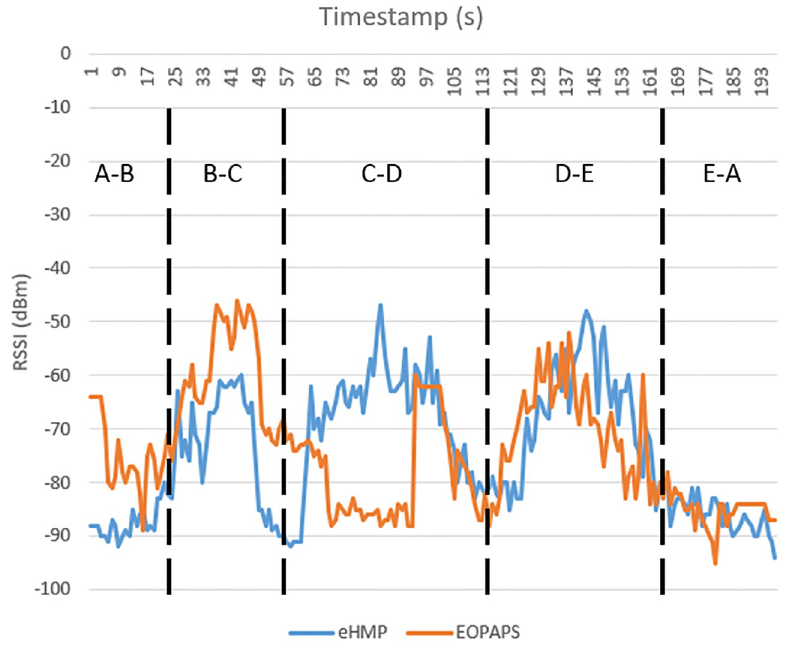
Fig 22. Instantaneous RSSI of EOPAPS and the proposed